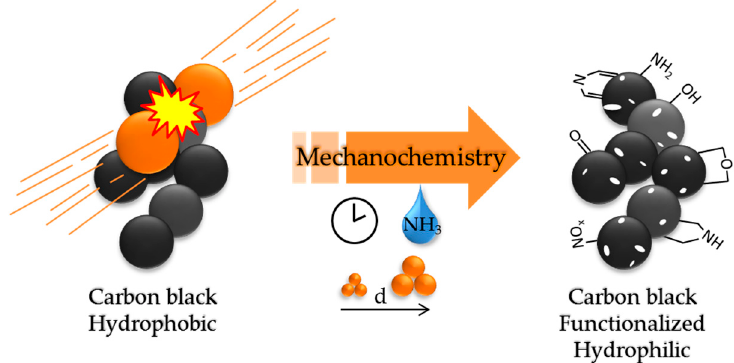
Figure 1. Scheme for the functionalization of carbon black in a ball mill.